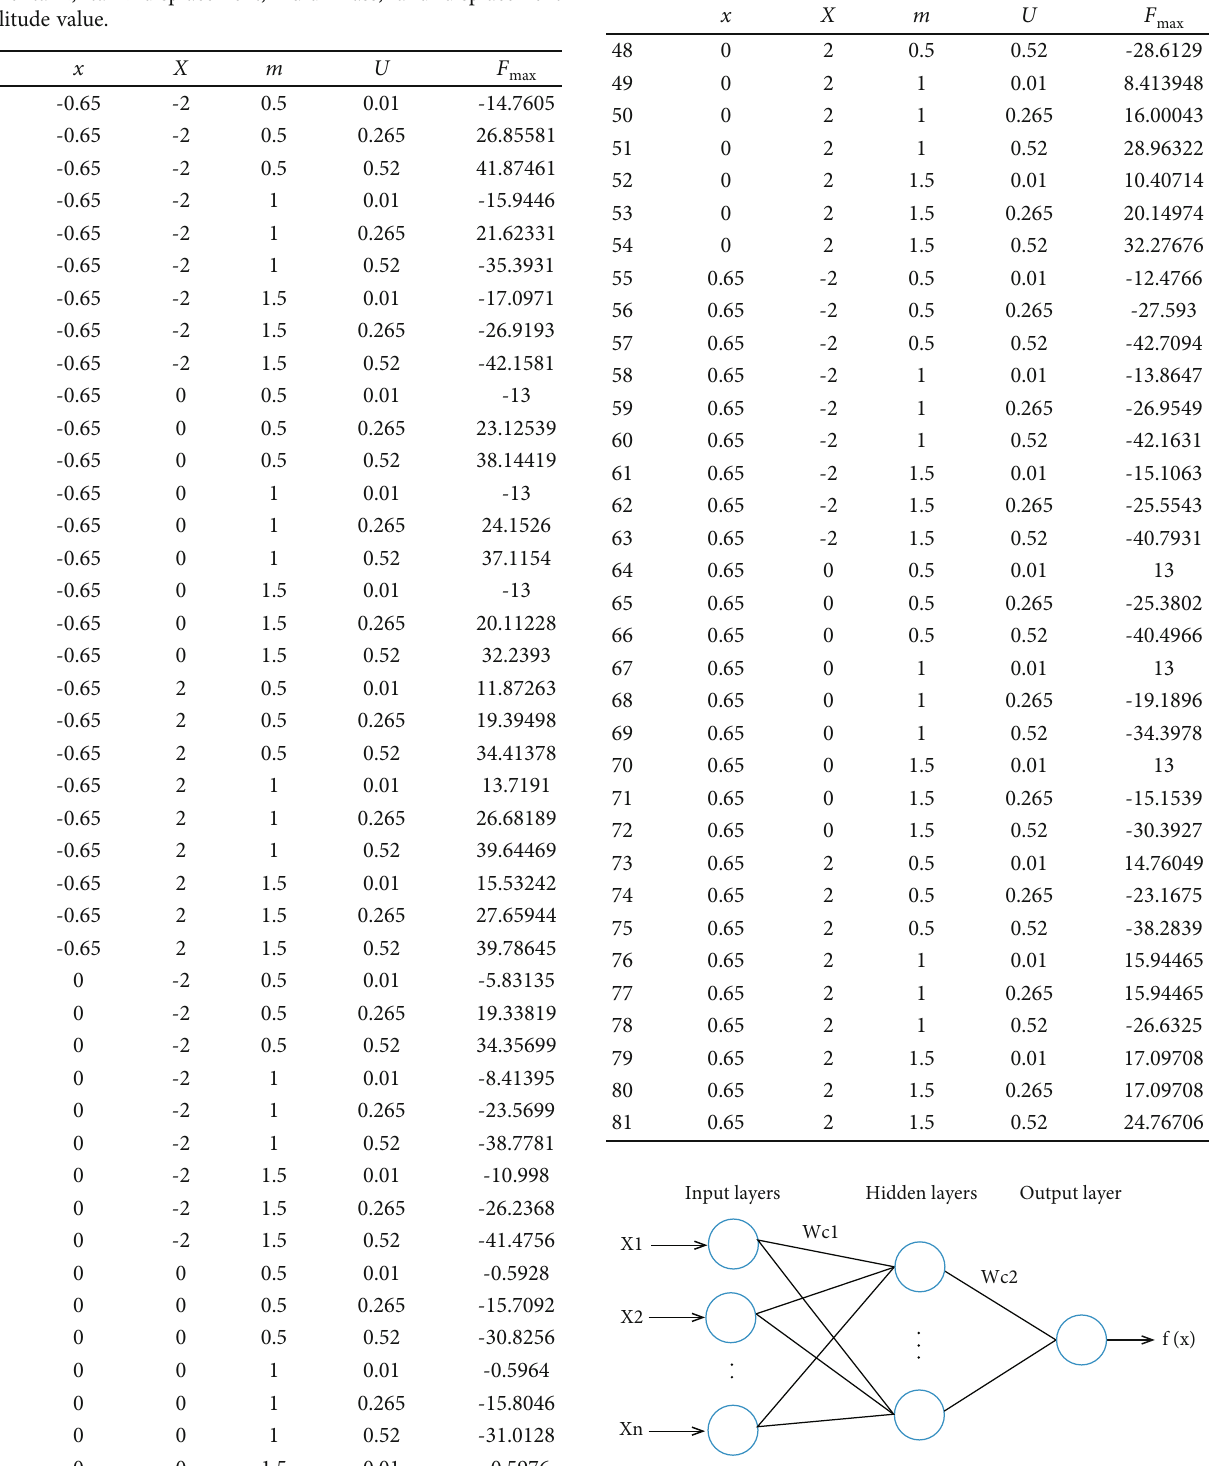
Table 2: The results are based on the parameters of fl uid position in the tank, tank displacement, fl uid mass, and displacement amplitude value.